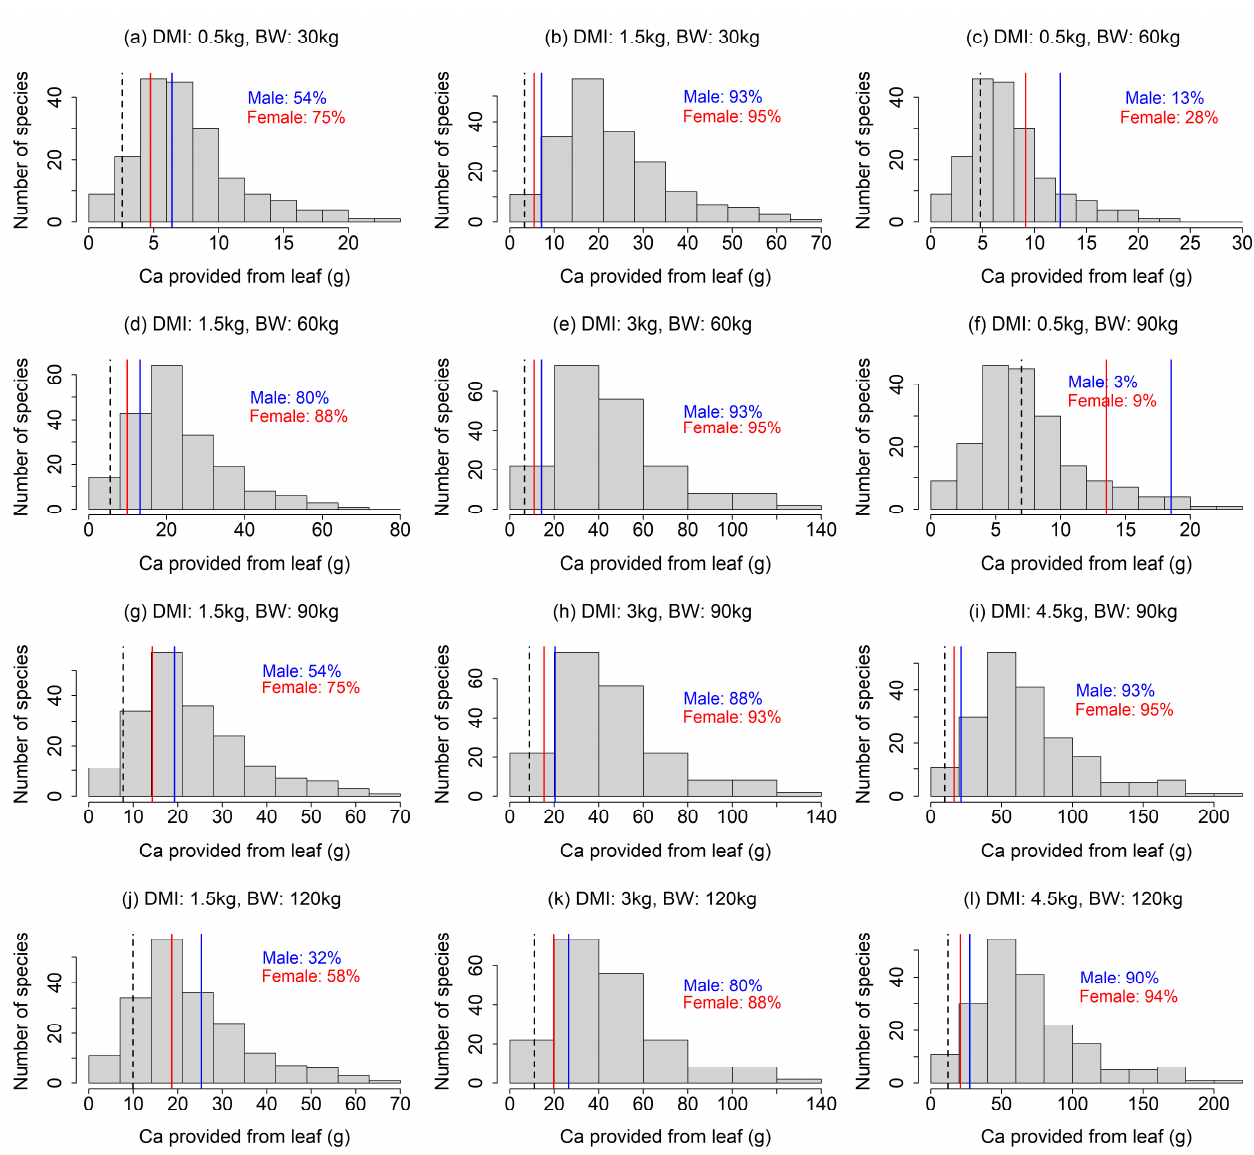
6 of 10 Figure 3. ( a – l ) Comparison of Mg provision by feed plants and the Mg requirement of sika deer under 12 scenarios (four dry matter intake levels × four body weights, excluding unrealistic scenar- ios). The histogram indicates the distribution of Mg provision calculated from the leaves of feed